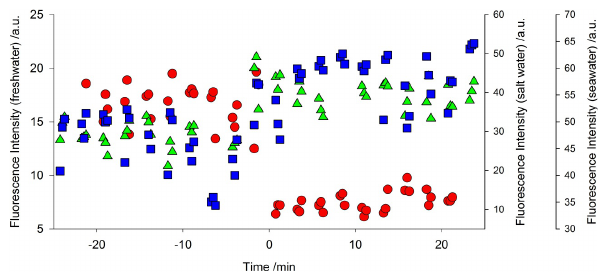
Fig. 2. Harmine fluorescence intensity (in arbitrary units) measured at 430nm following excitation at 320nm plotted as a function of time relative to the freezing of a freshwater sample (red circles, left axis), salt water (0.5MNaCl) sample (green triangles, inner right axis) and artificial seawater sample (blue squares, outer right axis).